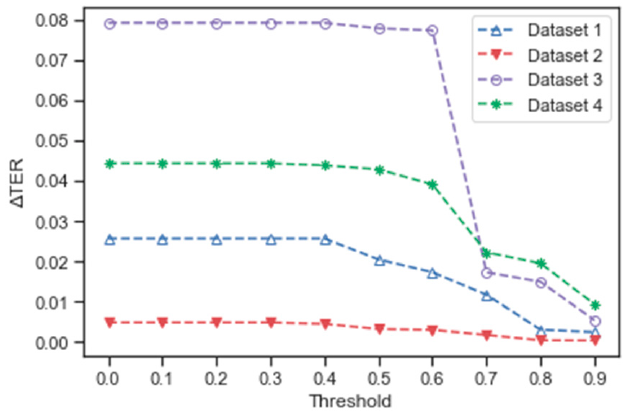
Figure 11. The curve of TER changes with respect to di ff erent thresholds of the test datasets.